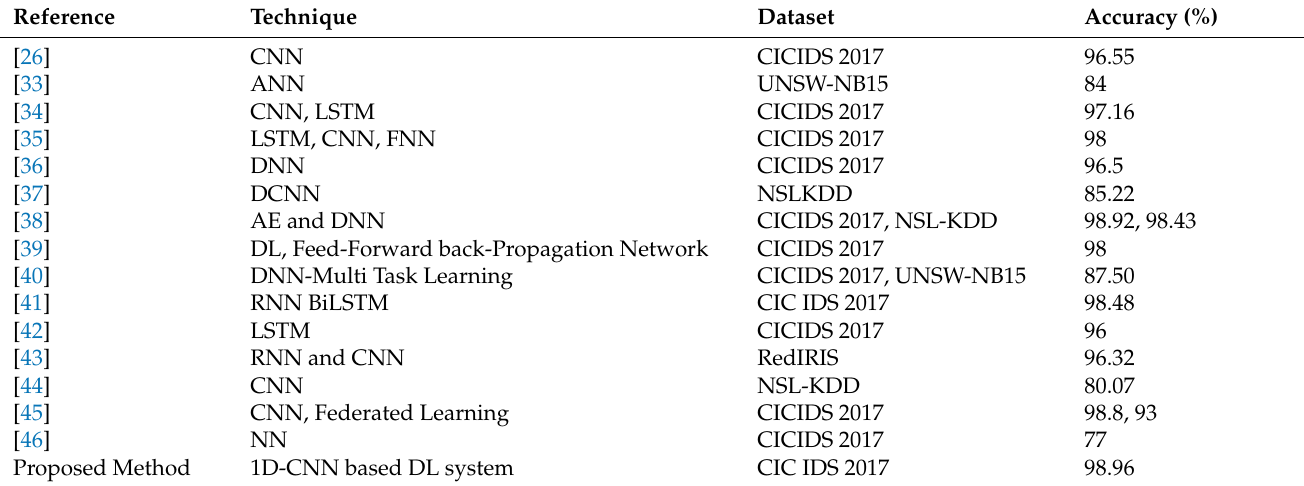
Table 10. Comparison with Existing Approaches.